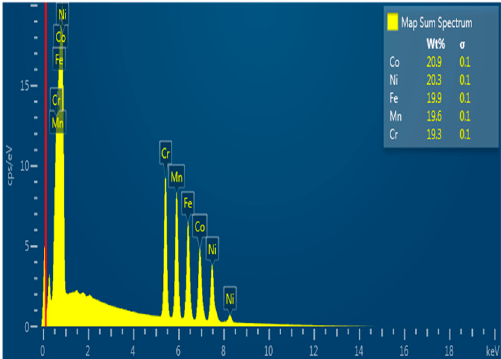
Figure 1. EDX spectrum of the CoCrFeMnNi HEA.